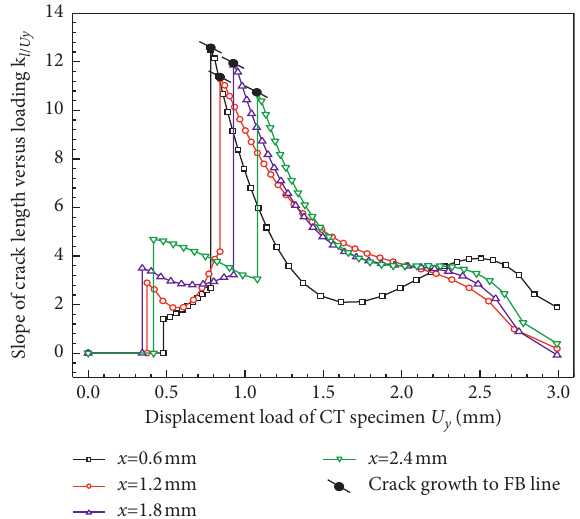
Figure 11: The crack propagation length with unit-load dis- placement curves.